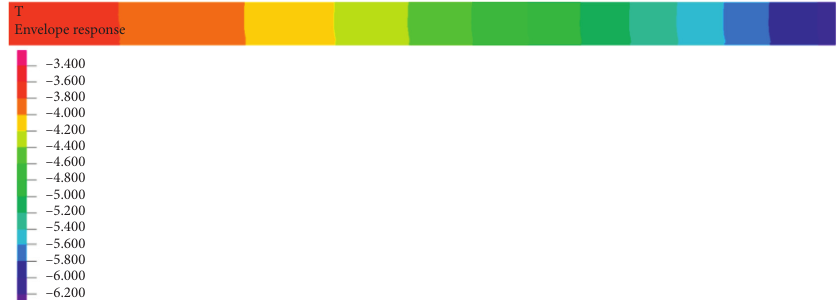
Figure 16: Annual average air temperature distribution in the tunnel axis with a thermal conductivity of 0.01W/(m · ° C).